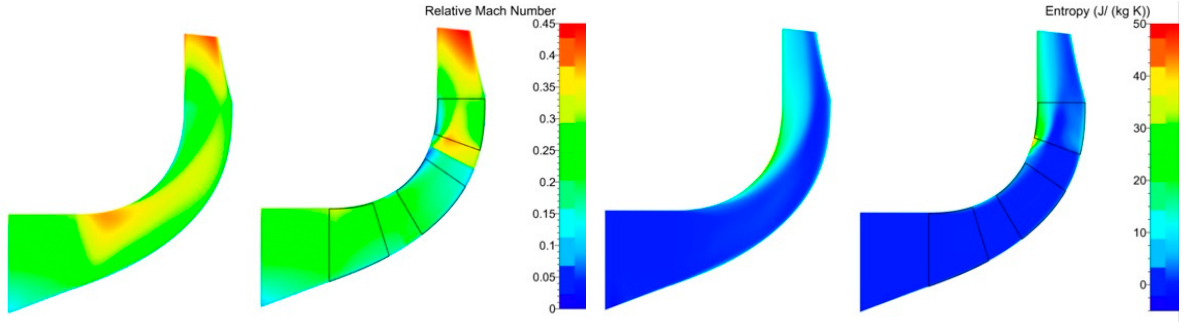
Figure 28. Mrel and entropy azimuthal contours of single and novel 1.5 stage compressor.